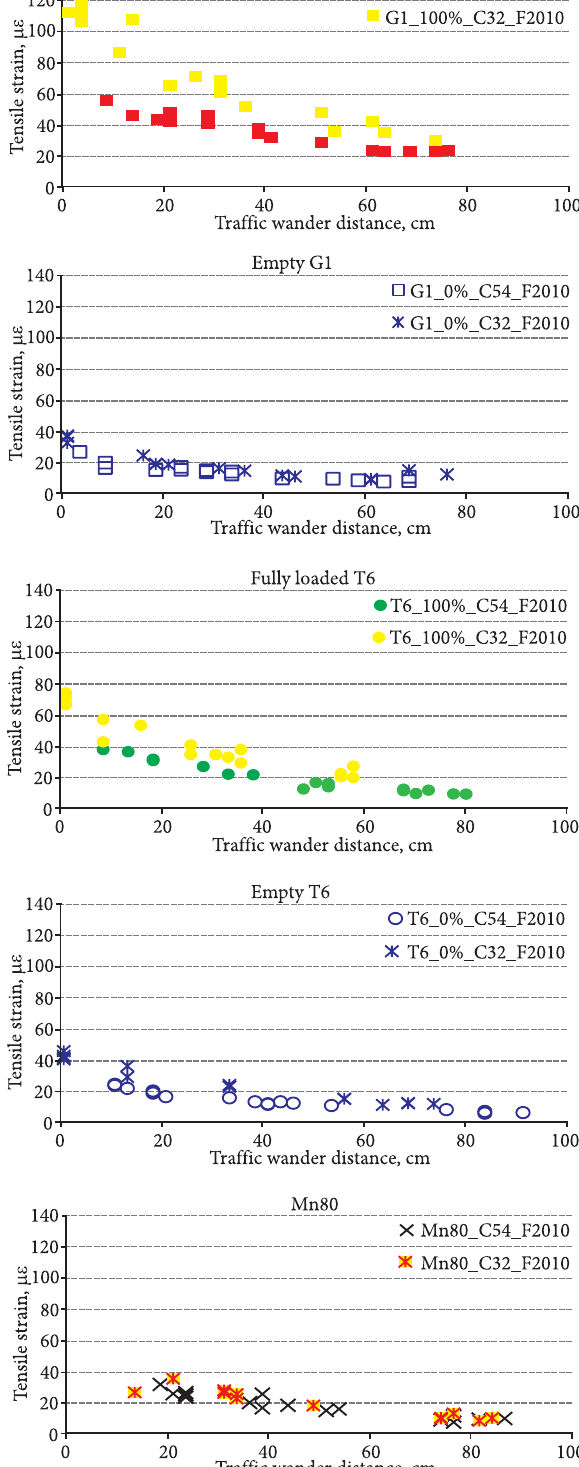
Fig. 8. Effect of tire type on tensile strains at the bottom of the PCC slab near mid-slab edge (S5 is fitted with flotation tires and S4 is fitted with radial tires)